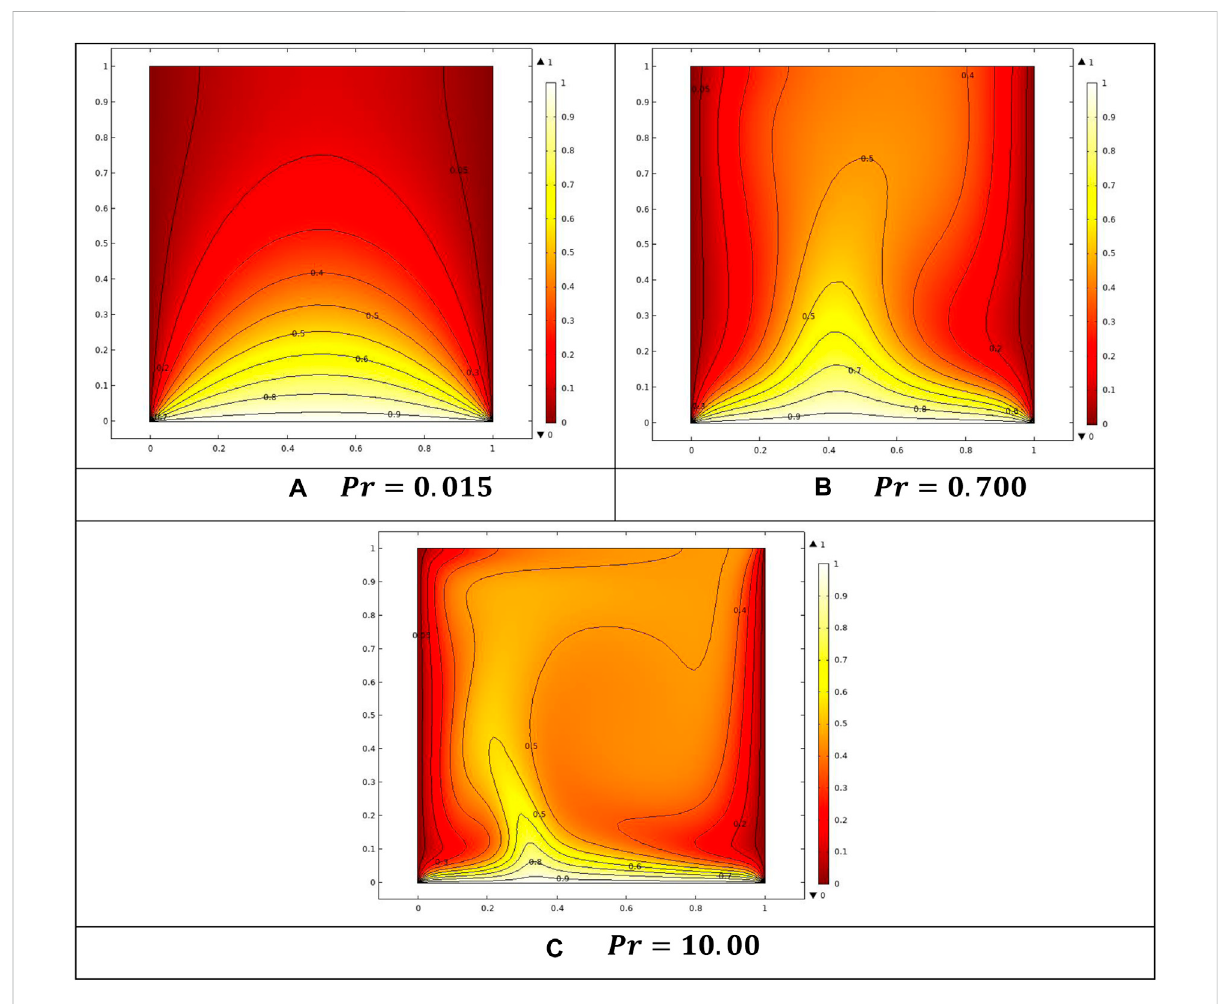
FIGURE 10 In fl uence of Pr on temperature distribution for the uniform heating case: (A) Pr (cid:1) 0 . 015, (B) Pr (cid:1) 0 . 700, and (C) Pr (cid:1) 10 .